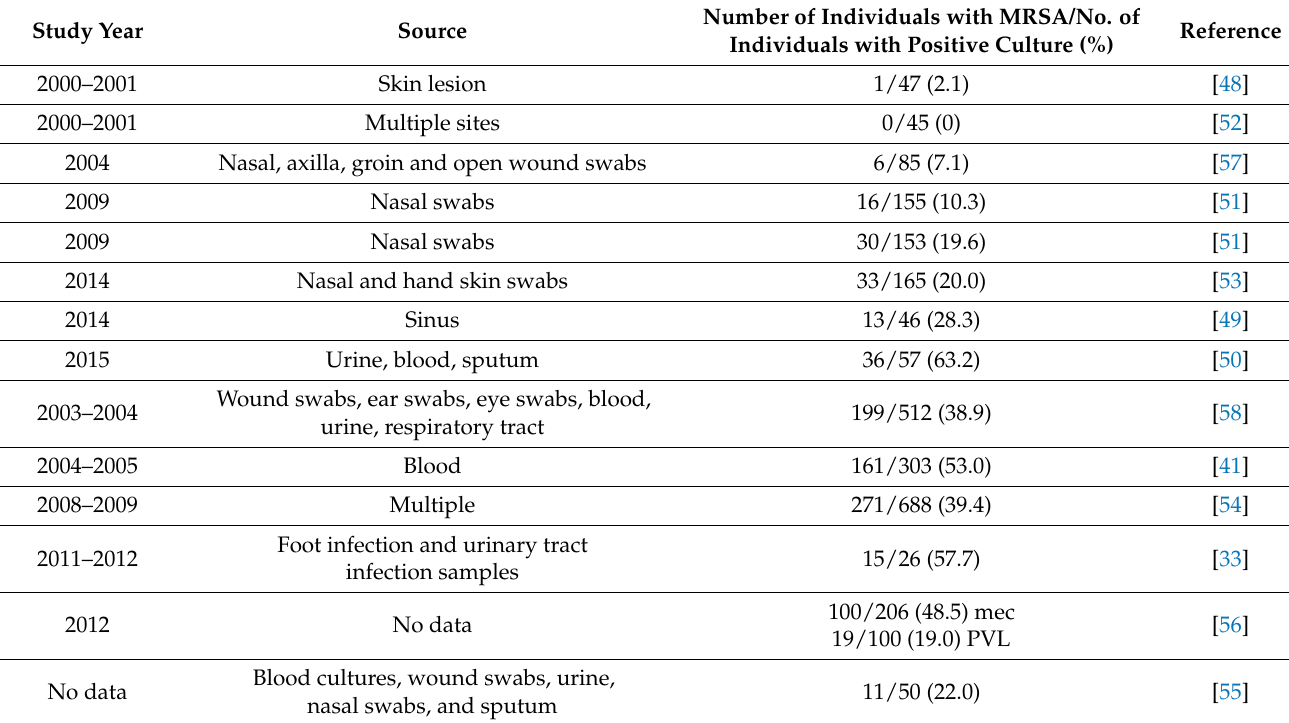
Table 2. A summary of Studies Examining Methicillin-Resistant Staphylococcus aureus in the Hajj pilgrims and workers. Study Year Source